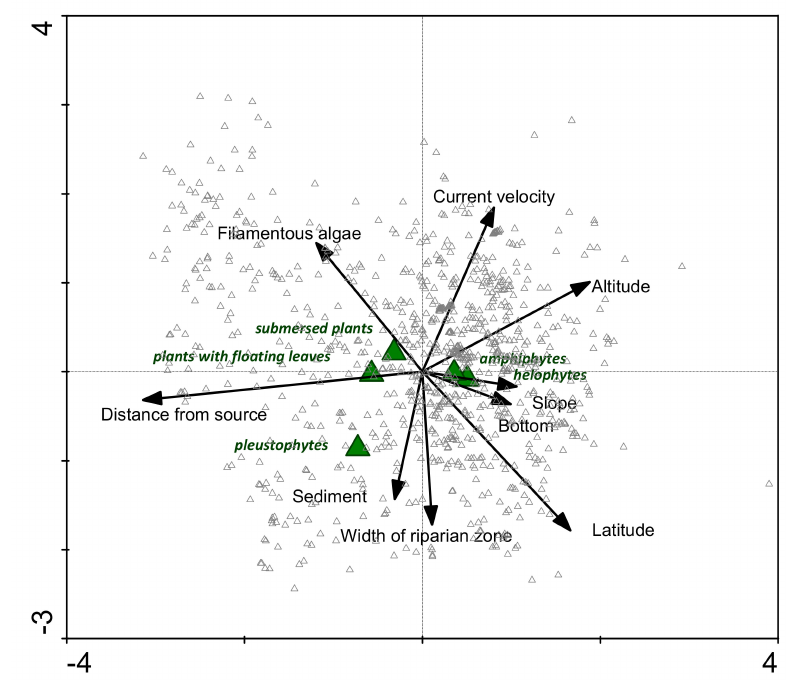
Figure 3. CCA (canonical correspondence analysis) plot showing the relationships between the abundance of different growth forms and significant environmental parameters detected in different stretches of the examined